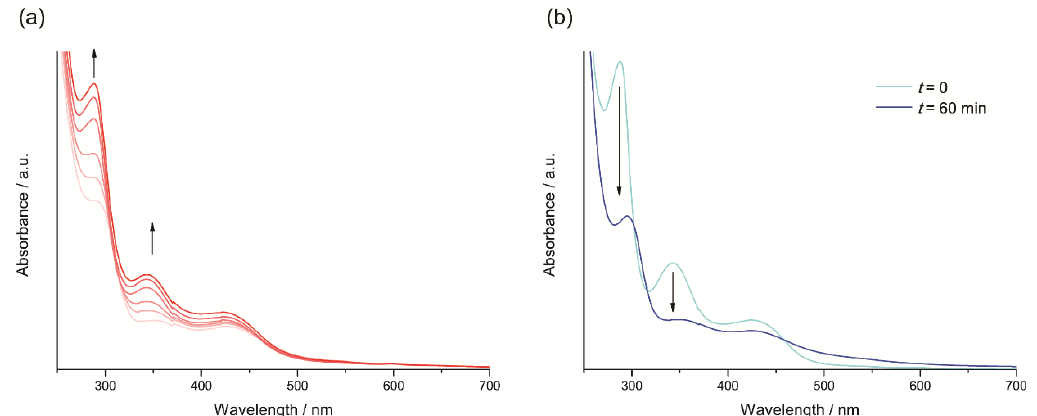
Figure 9. ( a ) UV-visible spectroelectrochemistry (UV / vis-SEC) data for [MnBr(CO) 3 (dpq)] in the CH 3 CN/2 equiv. of H + at − 0.6 V. ( b ) Spectral changes of [MnBr(CO) 3 (dpc)] in CH 3 CN under air. Molecules 2020 , 25 , x FOR PEER REVIEW 10 of 15